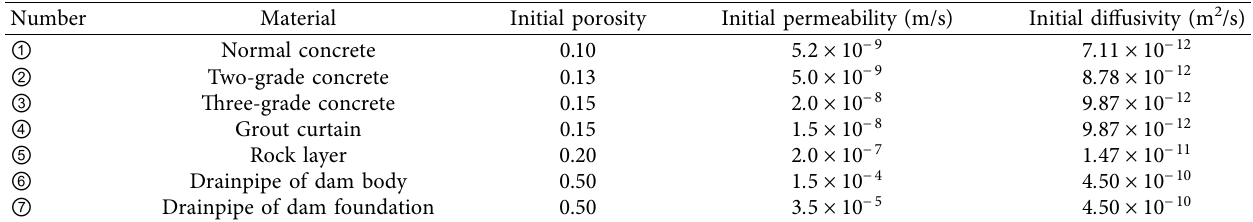
Figure 11: 3D finite element model of the Shimantan dam. Table 3: Calculation parameters of different materials.